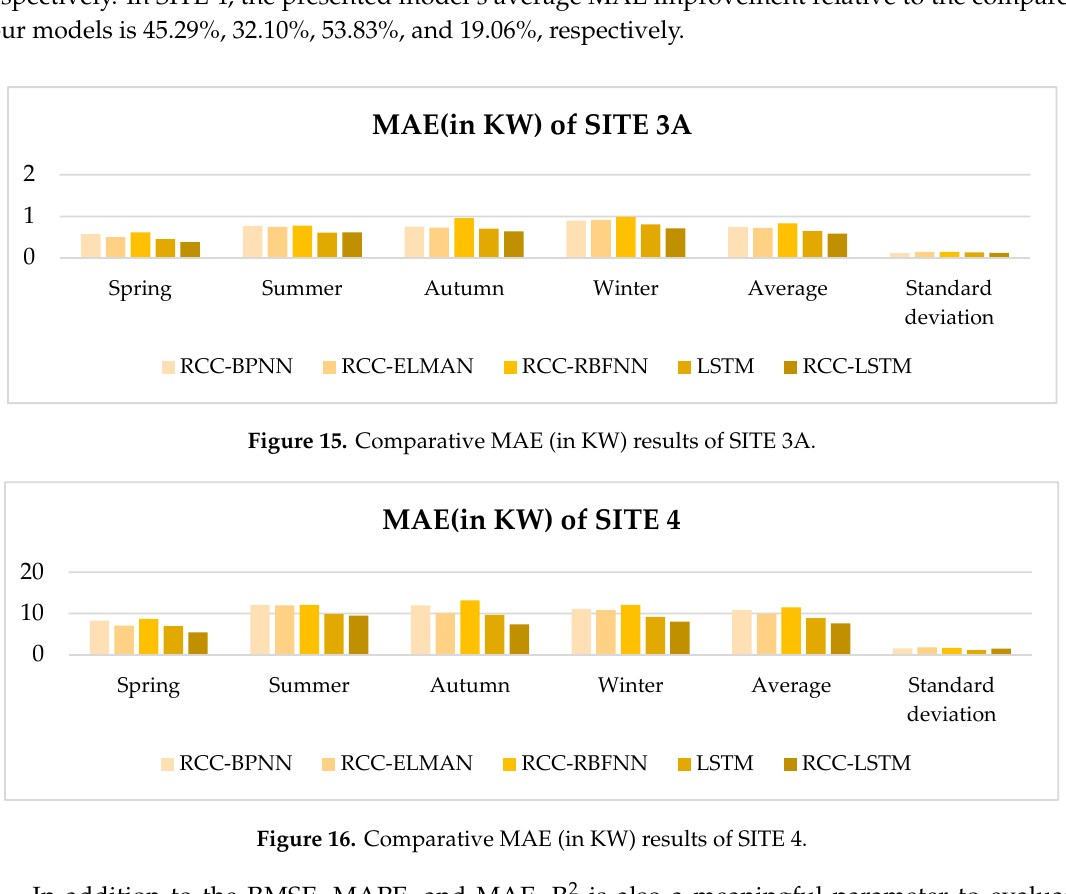
( b ) Figure 17. ( a ) The R 2 of different models in two PV systems; ( b ) The standard deviation of R 2 in two PV systems. Therefore, the RCC-LSTM model has outstanding performance in the VST prediction of PV generation, especially in desert areas where the weather changes are more moderate. As the data set accumulates, the forecasting result of cloudy weather will also be improved. The environment framework of this experiment is TensorFlow, which is implemented based on Python3.6 and a 64-bit operating system personal computer with Intel (R) Core (7M) i5-7300HQ CPU@2.50GHZ 2.50GHZ and 8.00GB of RAM. As shown in Figure 18, the average training time-cost at the different time points and the average runtime of every time point are shown in Figure 18a and Figure 18b, respectively. Owing to the same time periods collection strategy of the training set, the dataset of training is small. Thus, every real-time predict step only requires a few seconds, which is acceptable in practical applications. Furthermore, due to the training dataset of RCC-LSTM that selected by RCC, compared with LSTM model, the RCC-LSTM not only improves the accuracy of the prediction but also reduces the training time cost of the prediction model. The average training time- cost of RCC-LSTM is 28.84% lower than that LSTM, and the runtime will be much lower by improving the hardware environments or optimizing code.